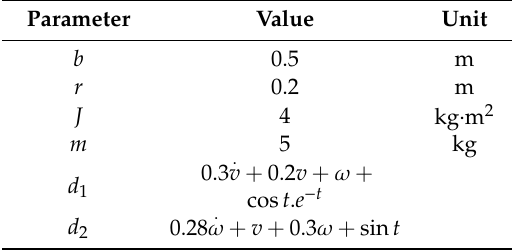
Table 1. List of system parameters for AGR.